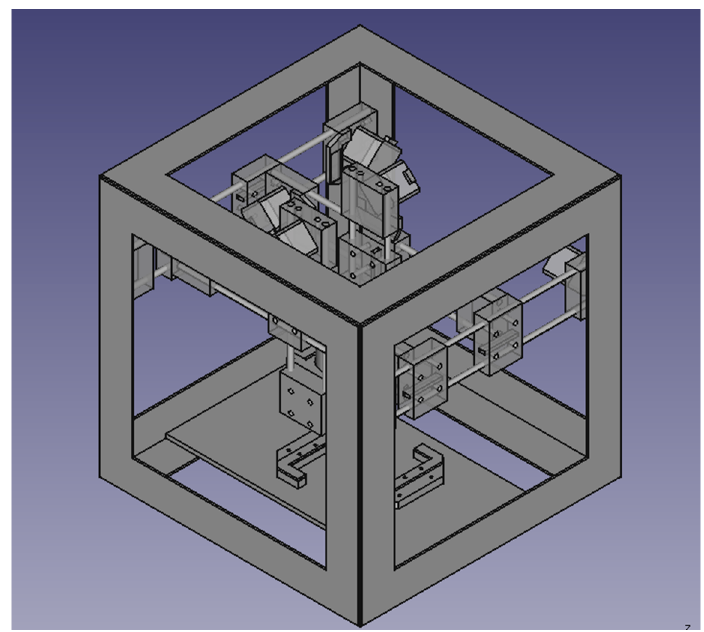
Figure 1. The FreeCAD model of the open source circuit mill.